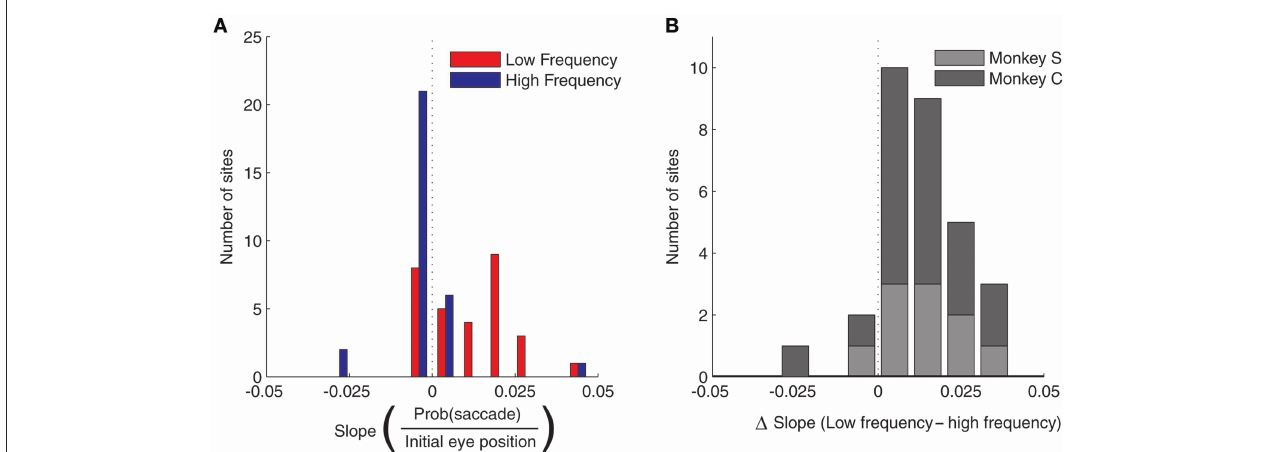
FIgure 8 | Population analysis of the effect of initial eye position on saccade probability. (A) Magnitude of slopes obtained from linear regression of saccade probability on initial eye position for each stimulation site. Data are shown for low (red) and high (blue) frequency stimulation conditions. Positive slope indicates a lower probability of evoking a saccade at more contralateral fixation positions. (B) . Differences in slope between low and high frequency